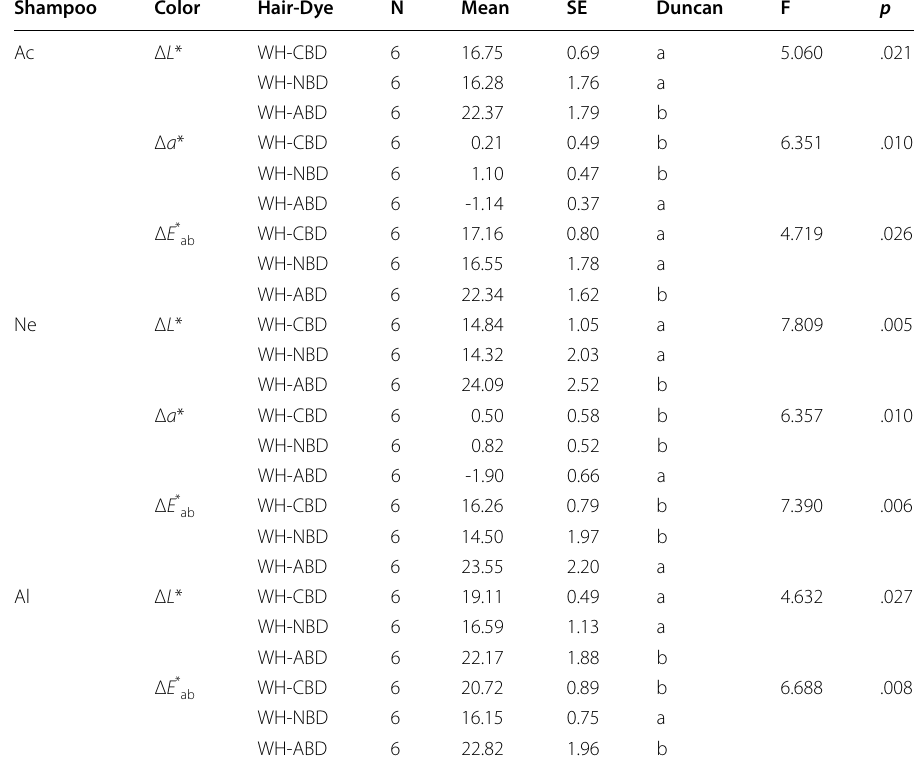
Table 8 Color difference of white hair (WH) by dye type after 10 times of shampooing using three different shampoos (α =